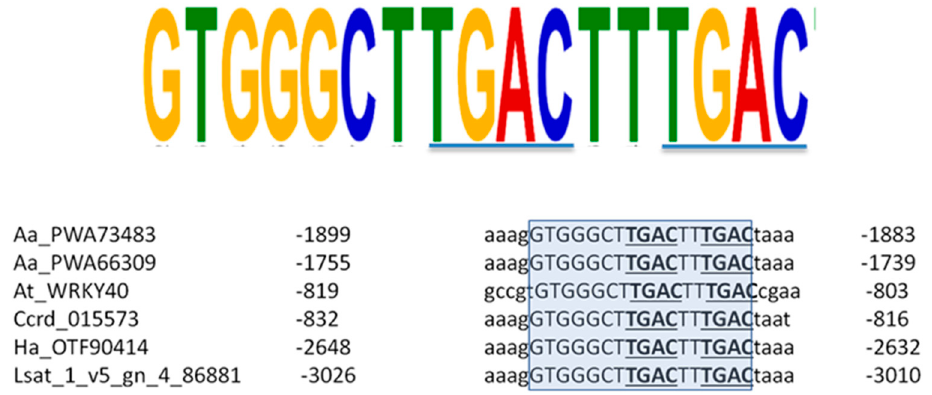
Figure 8. Results of the MEME analysis run on the promoter of WRKYs in group IIa. The highly conserved 17 nucleotides long sequence is shown. Conserved W-box TGAC core sequences are underlined. The identified double W-box is highlighted in light blue in the sequence alignment. Aa: Artemisia annua ; At: Arabidopsis thaliana ; Ccrd: Cynara cardunculus ; Ha: Helianthus annus ; Lsat: Lactuca sativa .